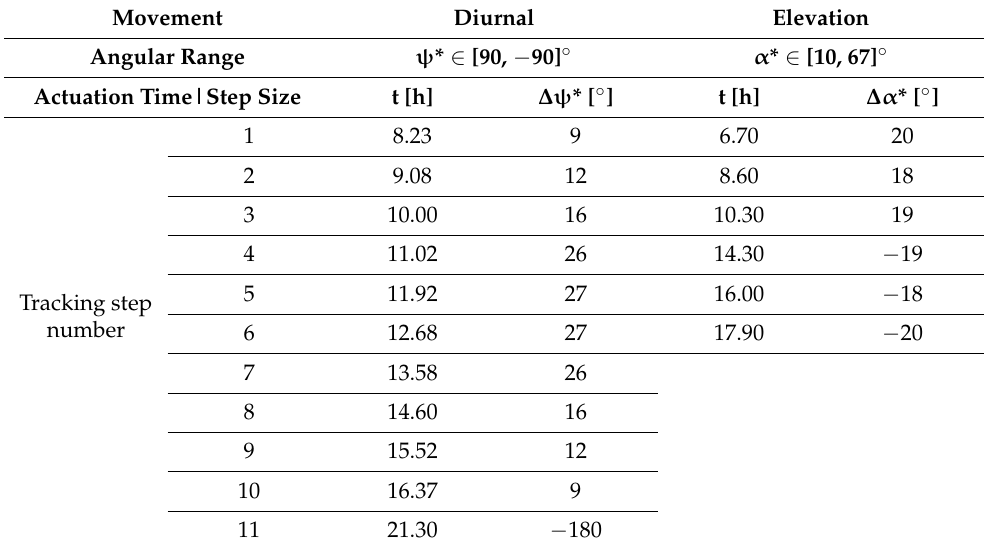
Table 8. Tracking program “7”.